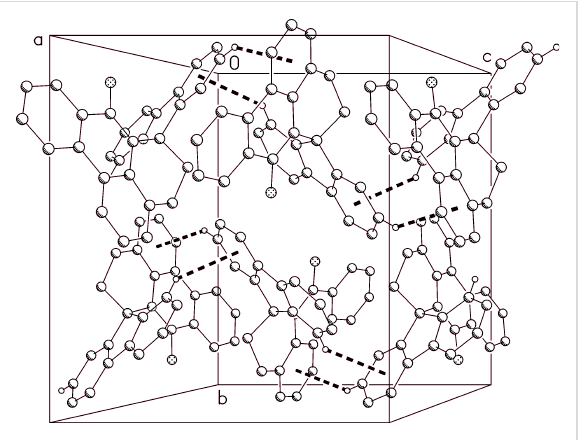
Figure 5: Packing diagram of compound 11 viewed perpendicular to the bc plane; hydrogen bonds C-H···π are indicated by dashed lines.